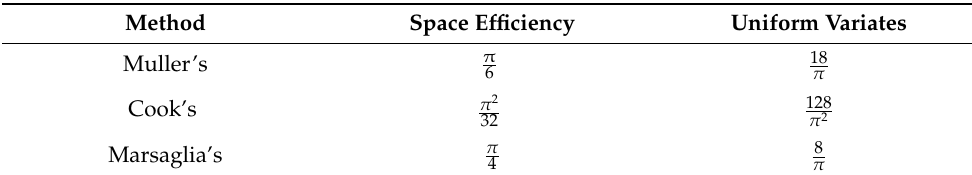
Table 3. Comparison of space occupation of three algorithms.